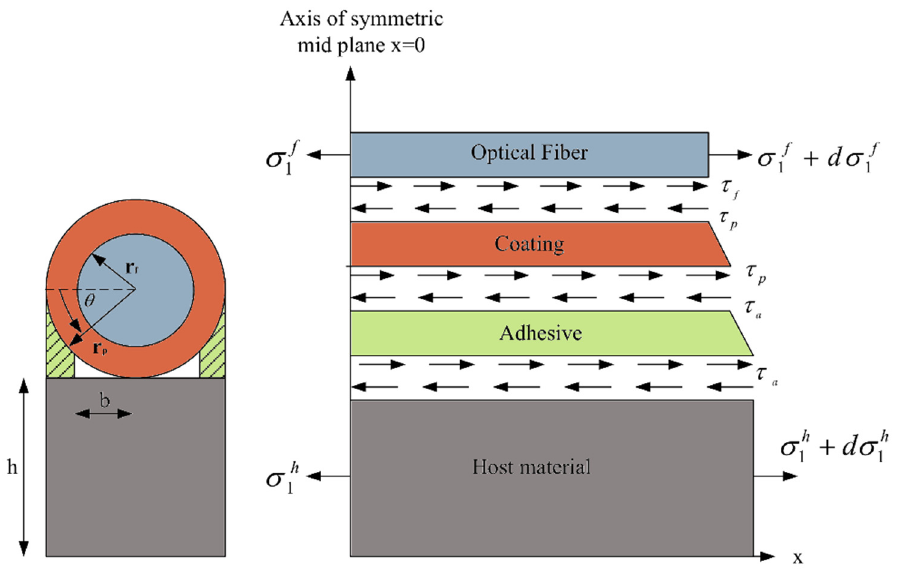
Figure 4. Free body diagram for the symmetrical section of the optical fiber and the substrates together with their relative shear transfer (adapted from [40]).